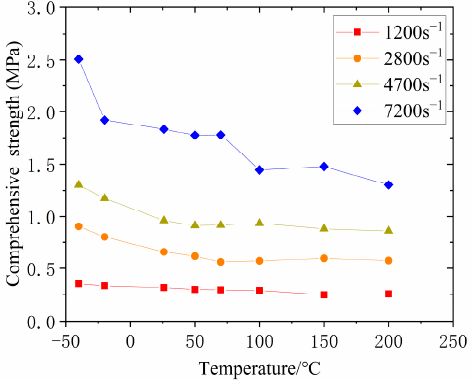
Figure 9. Relationship between yield strength and temperature.